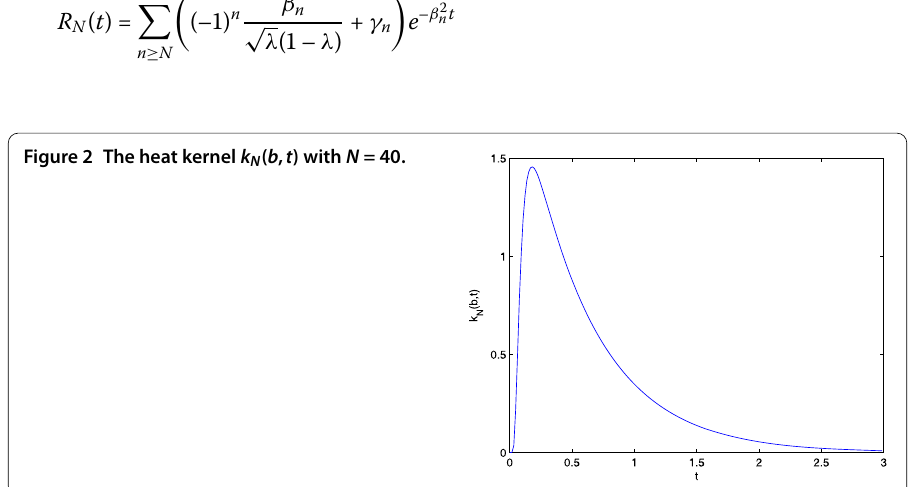
Figure 2 The heat kernel k N ( b , t ) with N =